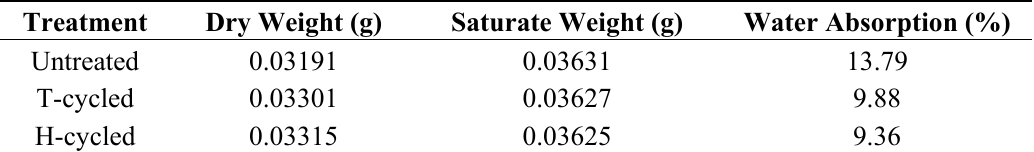
Table 1. Averaged weights of the specimens experienced different treatments and calculated water absorption percentages.